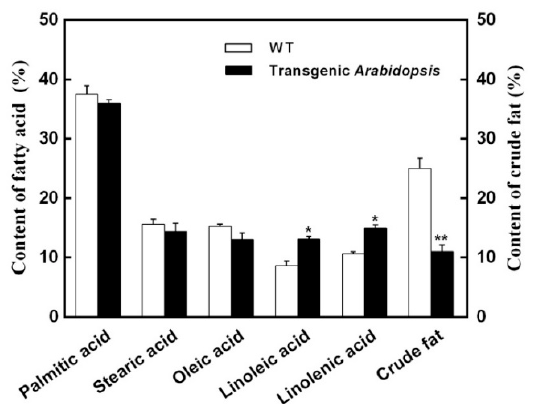
Figure 13. Contents of several types of fatty acids in the total fatty acids and the crude fats in seeds of wild type (WT) and the transgenic plants of Arabidopsis thaliana with GmPLMT . Symbols “*” and “**” indicate significant differences at p values of 0.05 and 0.01, respectively.